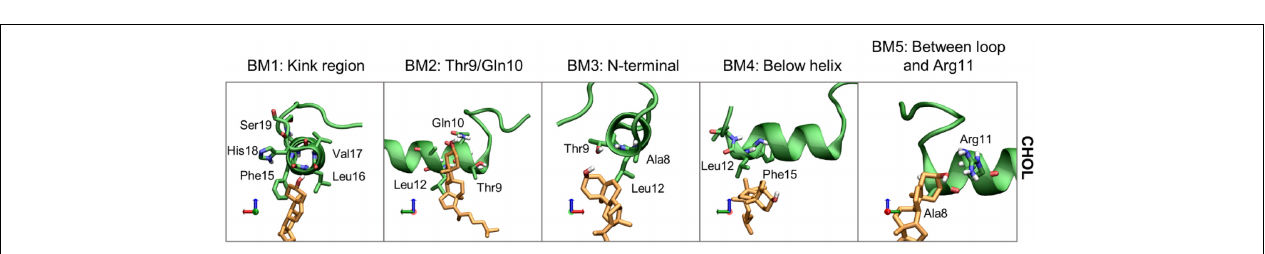
FIGURE 12 | Representative structures of the phospholipid binding modes (BM1-5), for (A) DOPC and (B) DOPS. IAPP is shown in green, with green carbons, and the lipids are shown with orange carbons.